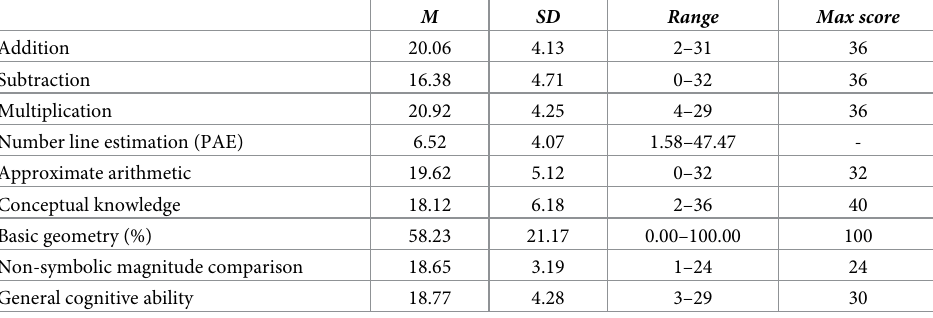
Table 1. Descriptive statistics and obtained range of all basic numerical measures (N =